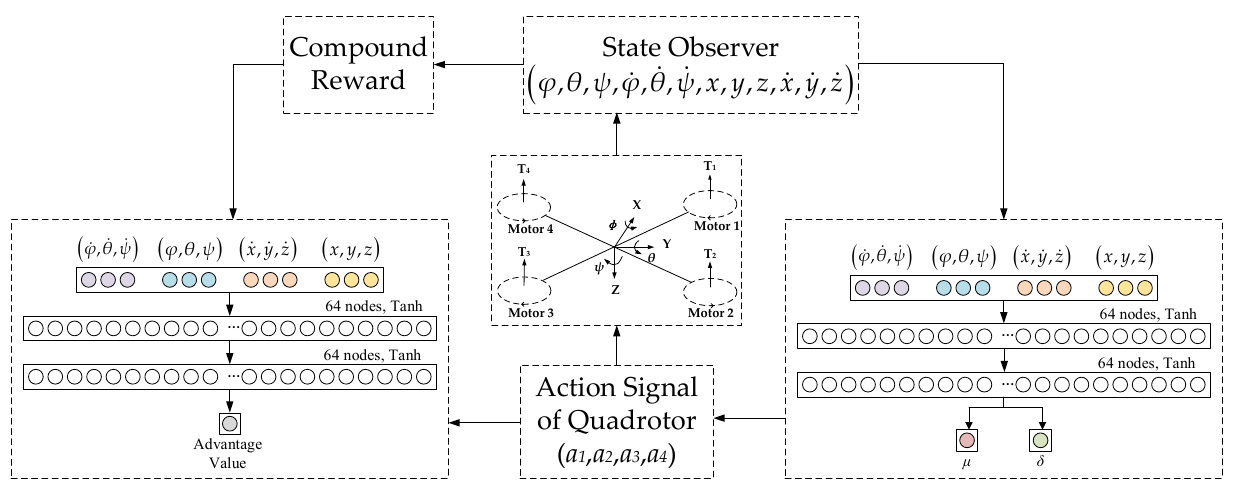
Figure 5. The structure of neural network.